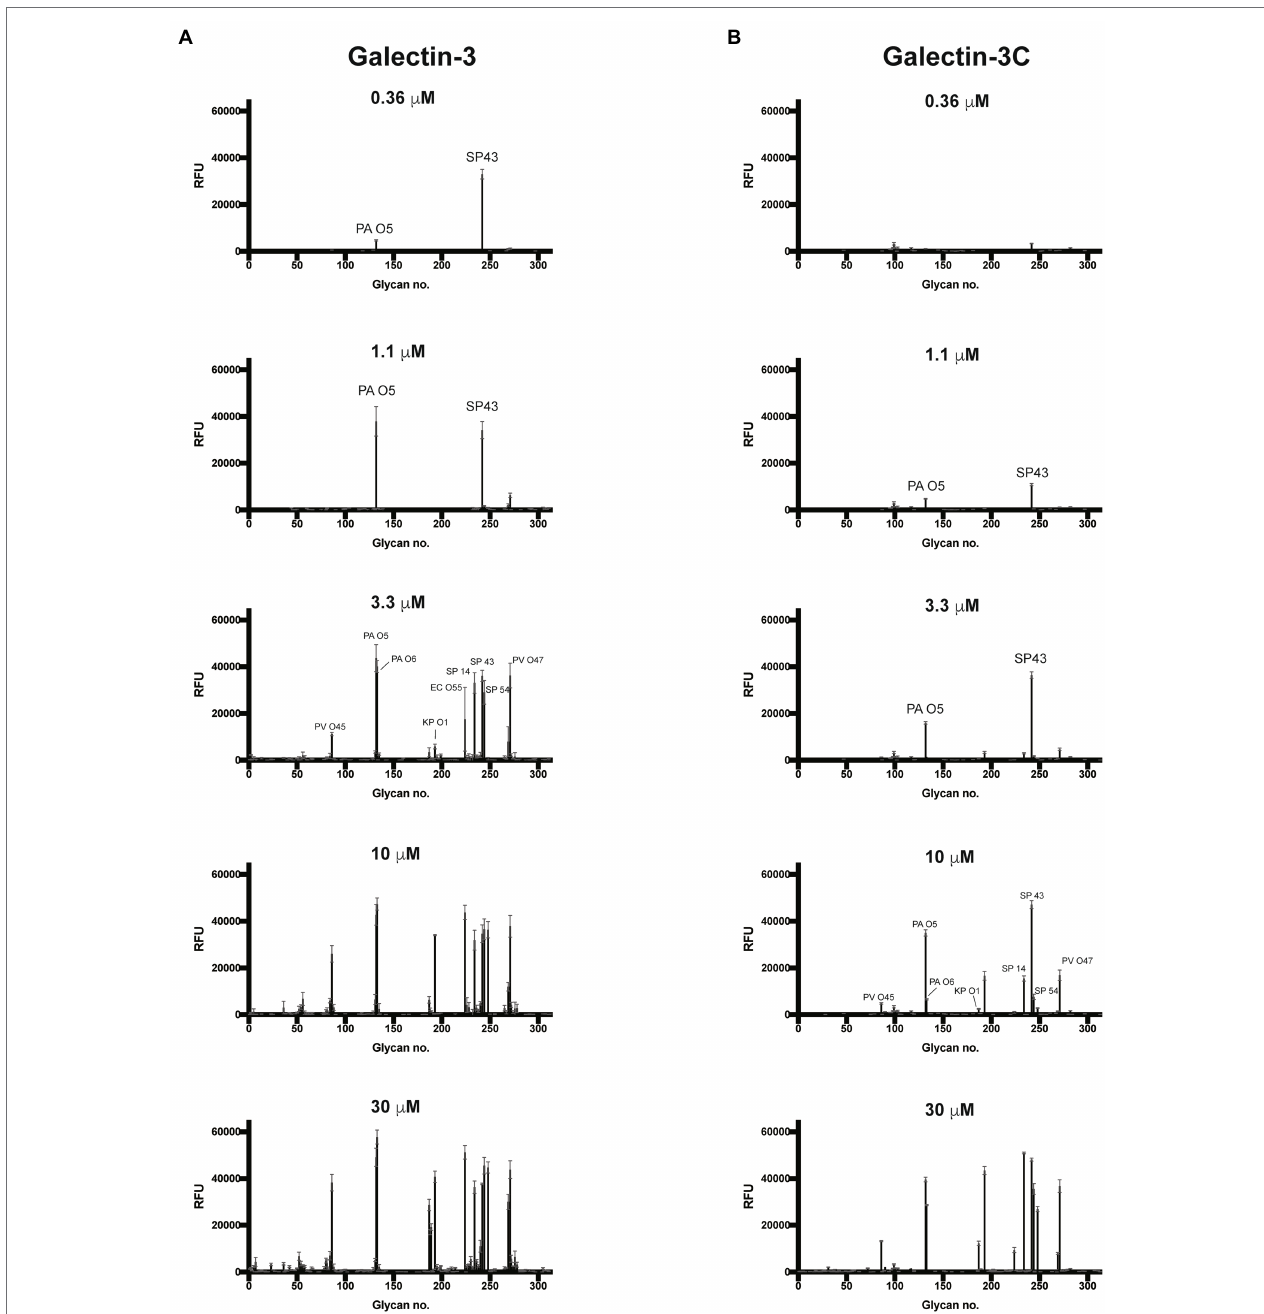
FIGURE 4 | Gal-3 and Gal-3C recognize distinct microbial glycans (A,B) Microbial glycan microarray (MGM) data obtained after incubation with the Gal-3 (A) or Gal-3C (B) at the concentrations indicated. Error bars represent means ± standard deviation (SD). RFU, relative fluorescence units; PA O5, Providencia alcalifaciens O5; PA O6, P. alcalifaciens O6; KP O1, Klebsiella pneumoniae O1; SP 14, Streptococcus pneumoniae type 14; SP 43, S. pneumoniae type 43; SP54, S. pneumoniae type 54; PV O45, Proteus vulgaris O45; PV O47, P. vulgaris O47; EC O55, Escherichia coli